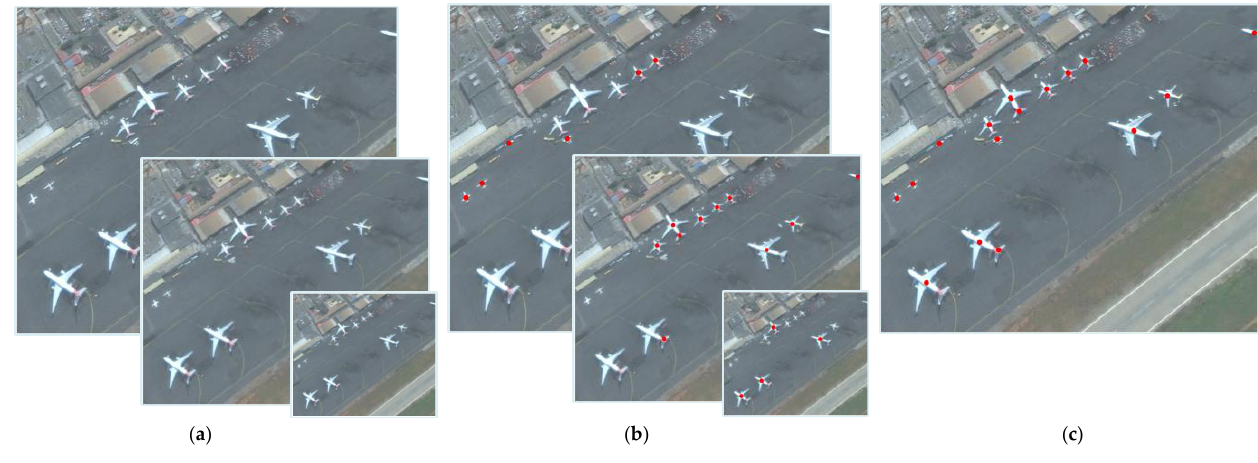
Figure 6. Multi-scale image pyramid and the results of aircraft target center determination. ( a ) Origin image pyramid; ( b ) center determination on image pyramid; ( c ) center point aggregation.